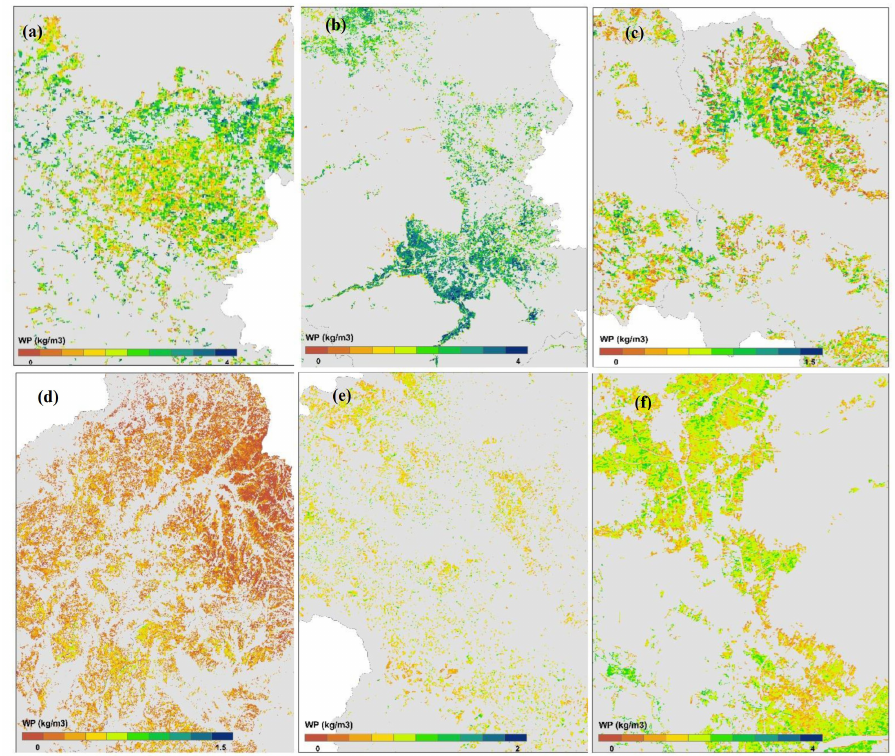
Figure 9. Examples of spatial maps of WP in LUB: ( a ) WP for grapes in WLUB, ( b ) WP for apples in WLUB, ( c ) WP for rainfed wheat in SWLUB, ( d ) WP for rainfed wheat in SLUB, ( e ) WP for irrigated wheat in SLUB, and ( f ) WP for grapes in